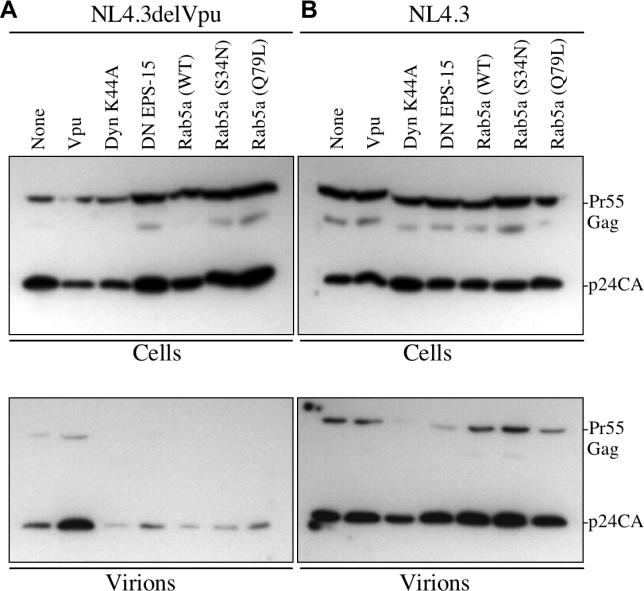
Inhibition of Endocytosis or Early Endosome Function Does Not Restore Vpu-Deficient HIV-1 ReleaseHeLa cells were transfected with NL4.3 (A) or NL4.3delVpu (B) proviral plasmids along with plasmids expressing GFP or Vpu (as controls), dynamin K44A, DN EPS-15, or wild-type and mutant Rab5a proteins. Cell and virus lysates were harvested 48 h post-transfection, and analyzed by Western blotting with an HIV-1 CA-specific monoclonal antibody